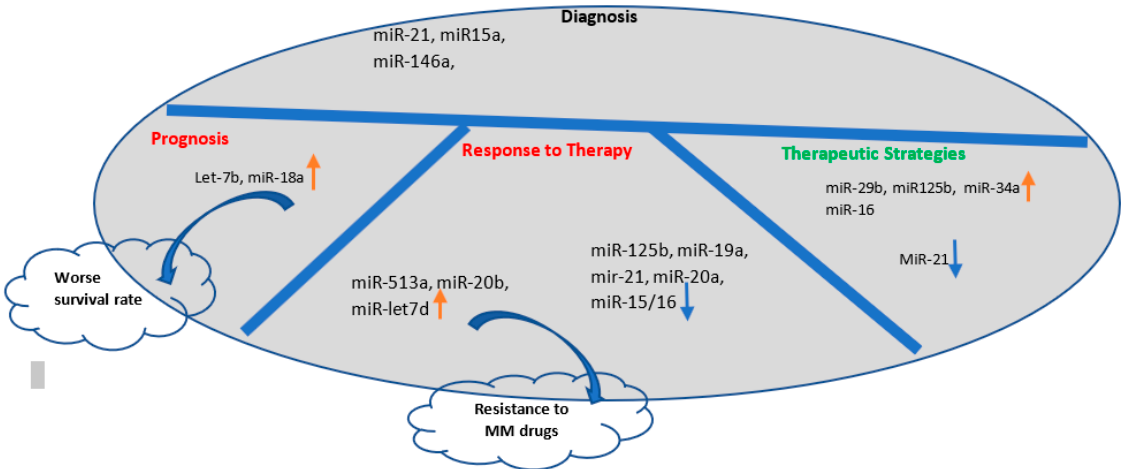
Figure 3. The applications of the exosomal miRNAs in the clinical practice: Exosomal miRNAs are potential diagnostic biomarkers for early detection of MM progress and they are examined for their prognostic potential. In addition, exosomes can be engineered for delivery of therapeutic miRNAs to increase their expression or targeting them to improve the immune response or induction of MM cell apoptosis by reprograming gene expression in the target cells (blue downward arrow shows downregulation and orange upward arrow shows upregulation of miRNAs).